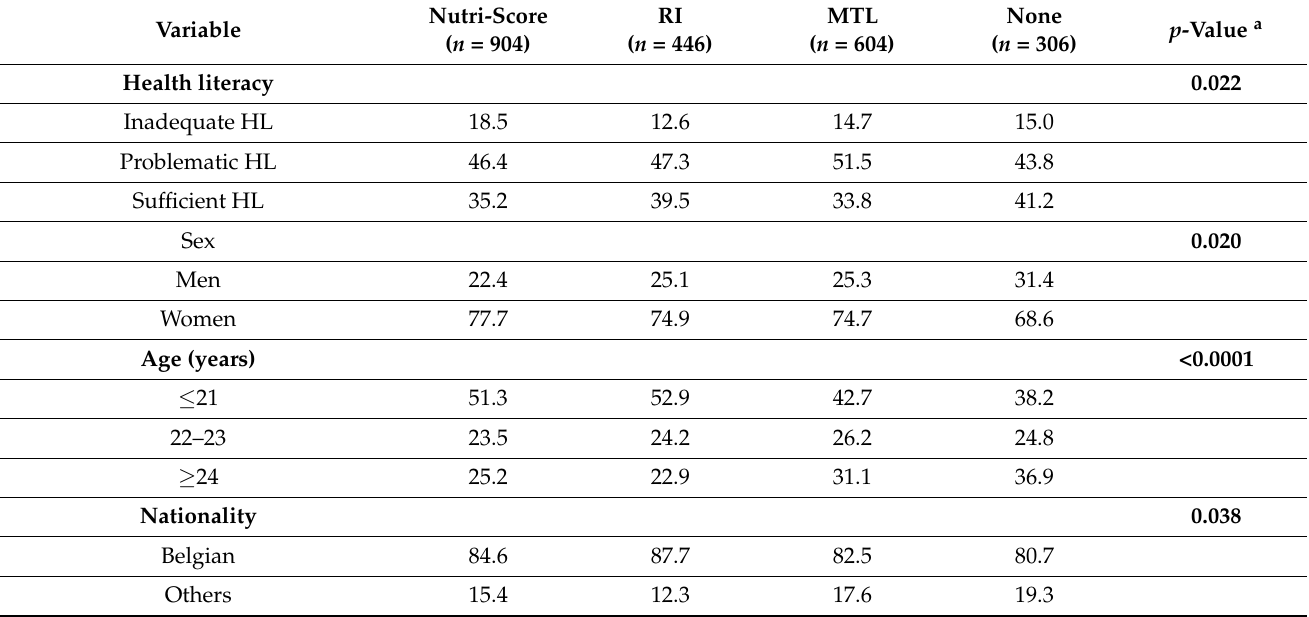
Table 4. Multivariate-adjusted HL and students’ characteristics according to the various clusters of preference for FOP